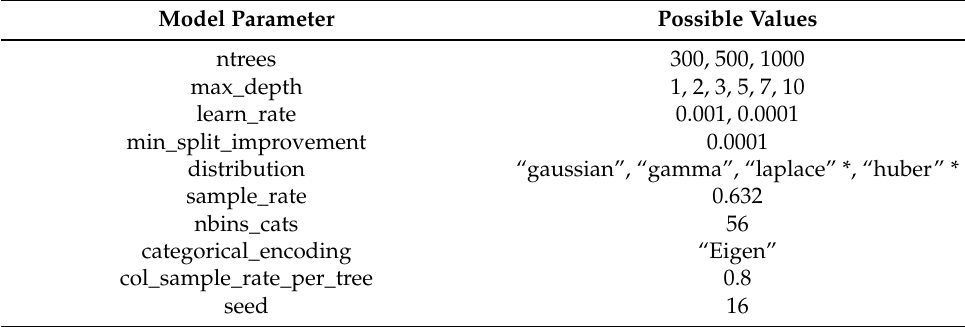
Table 11. Tuning Parameters for Gradient Boosted Forest Severity Models.